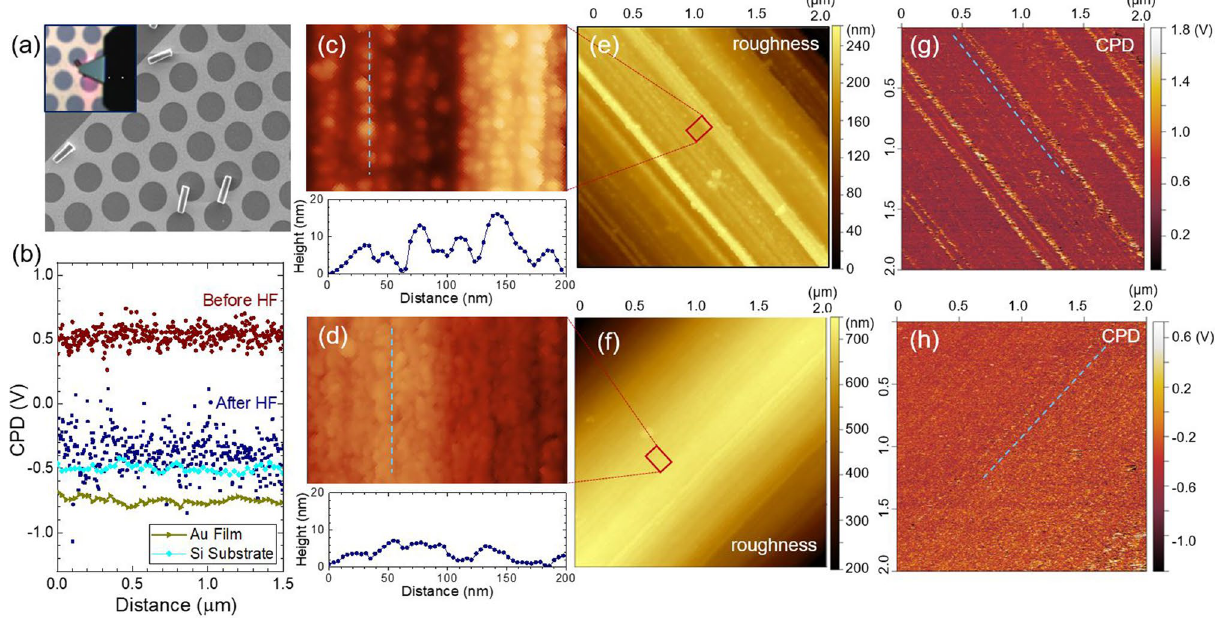
Figure 4. ( a ) Scanning electron microscopy (SEM) image of the dispersed Si micropillars on a patterned Au film on Si. The inset illustrates the Kelvin-probe force microscopy (KPFM) configuration, where a KPFM probe is scanning the sidewall of a Si pillar. ( b ) Contact potential difference (CPD) obtained on the Si pillars and the planar controls (Au film, Si substrate). Atomic force microscopy (AFM)/KPFM performed on the Si pillar sidewalls before ( c , e , g ) and after ( d , f , h ) removing SiO x in